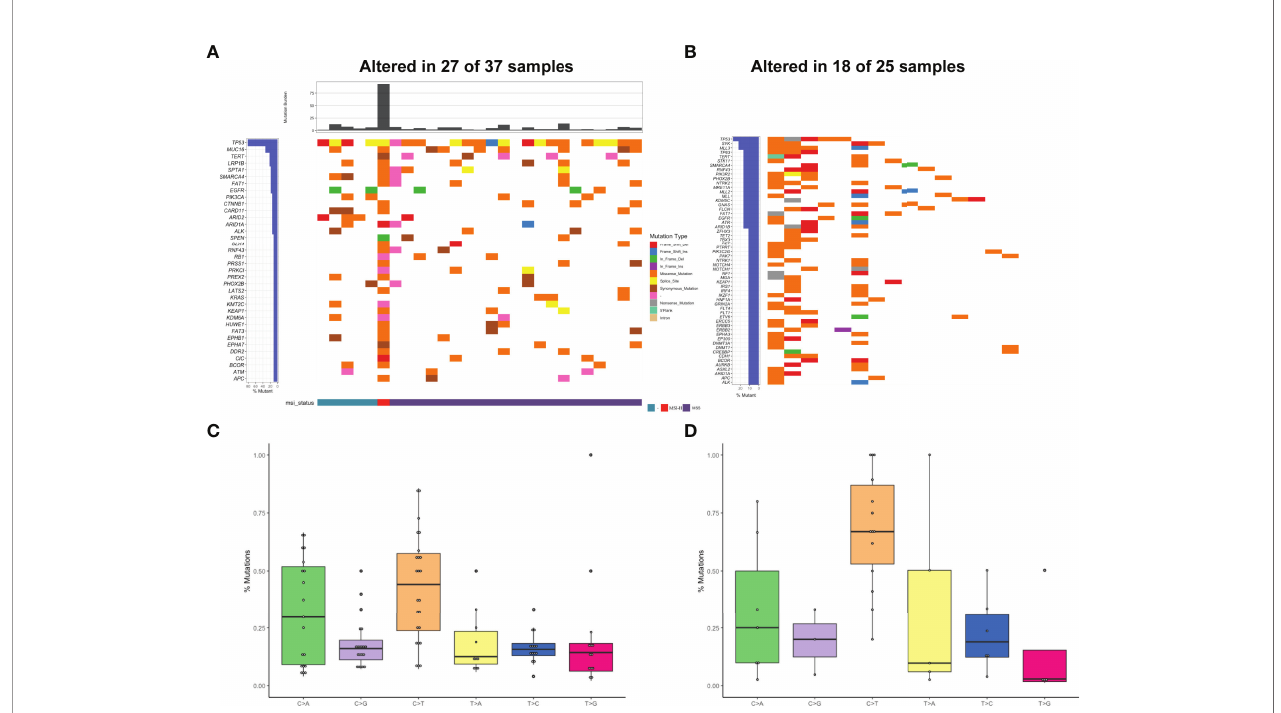
FIGURE 3 | Mutational pro fi les and partners of NTRK fusion-positive patients. (A) The oncoprint of the somatic SNVs in 37 patients harboring NTRK fusion in our study. (B) The oncoprint of the somatic SNVs in 25 patients harboring NTRK fusion in the MSKCC database. (C) Mutational signatures of NTRK fusion positive patients in our cohort. (D) Mutational signatures of NTRK fusion-positive patients in the MSKCC